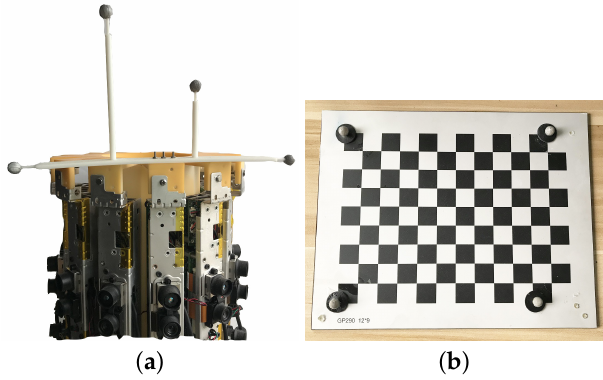
Figure 5. ( a ) Kinect with reflective markers. ( b ) Chessboard with reflective